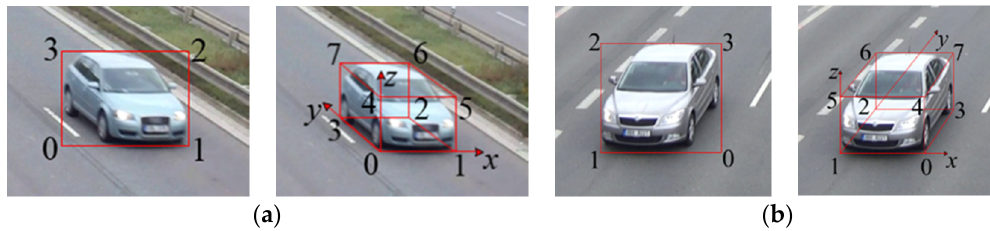
Figure 6. Schematic diagram of vehicle model of 2D/3D bounding box from different perspectives. ( a ) Left perspective; ( b ) Right perspective. Table 1. Eight vertices and projection centroid in 3D bounding box model from different perspectives.